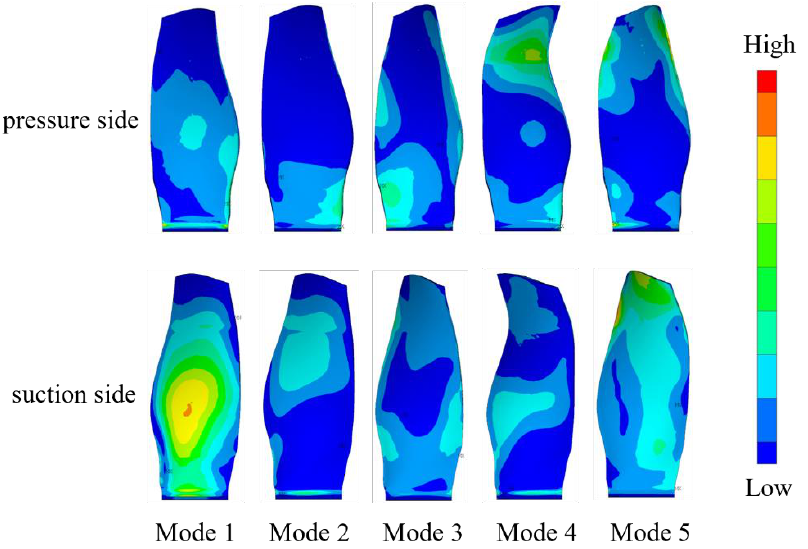
Figure 6. Modal strain contour. Table 2. Test frequency and FE simulation frequency.